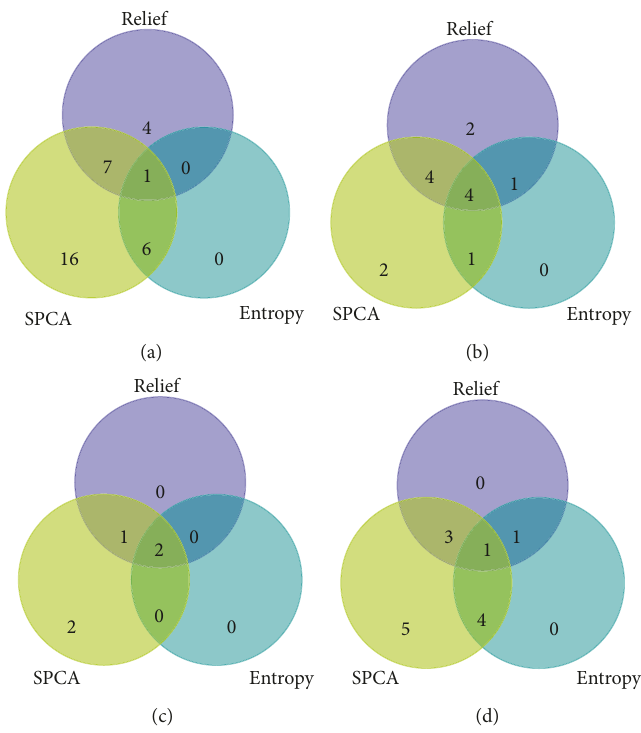
Figure 4: Venn plots of (a) SNPs, (b) demographic characteristics, (c) lifestyle, and (d) food.